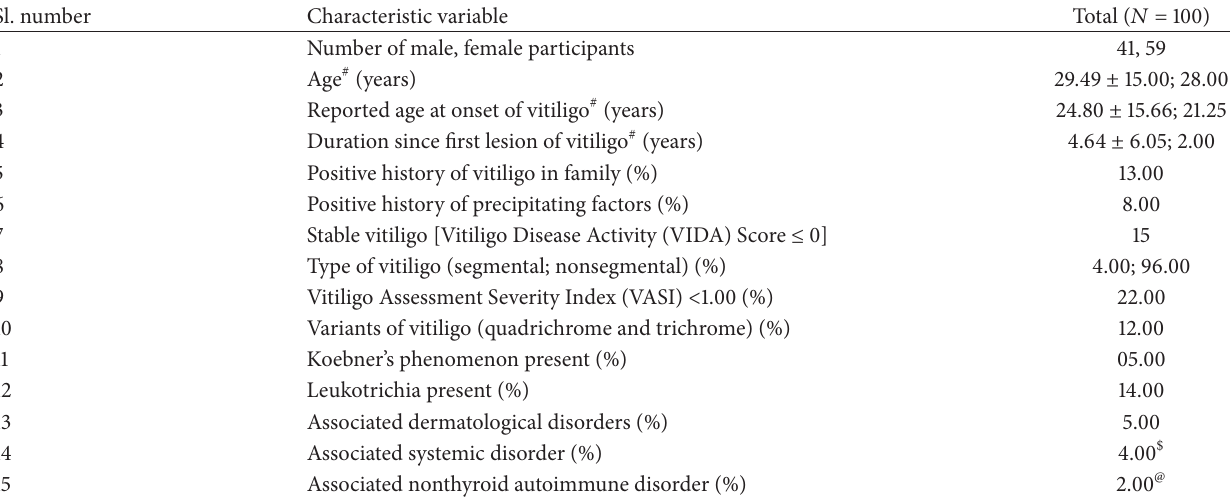
Table 1: Sample characteristics of study participants.